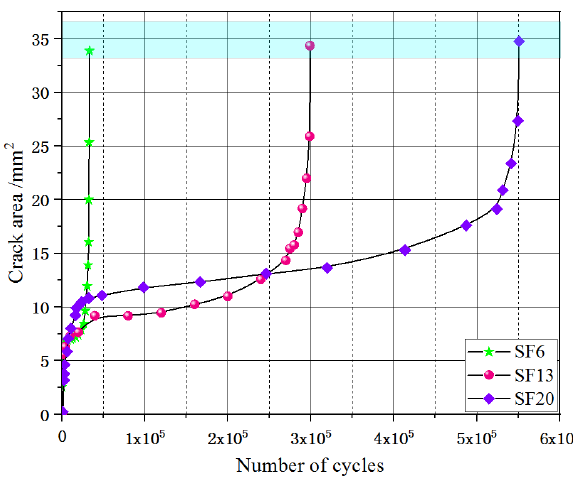
Figure 9. Calculating the crack area by using the DIC technique.